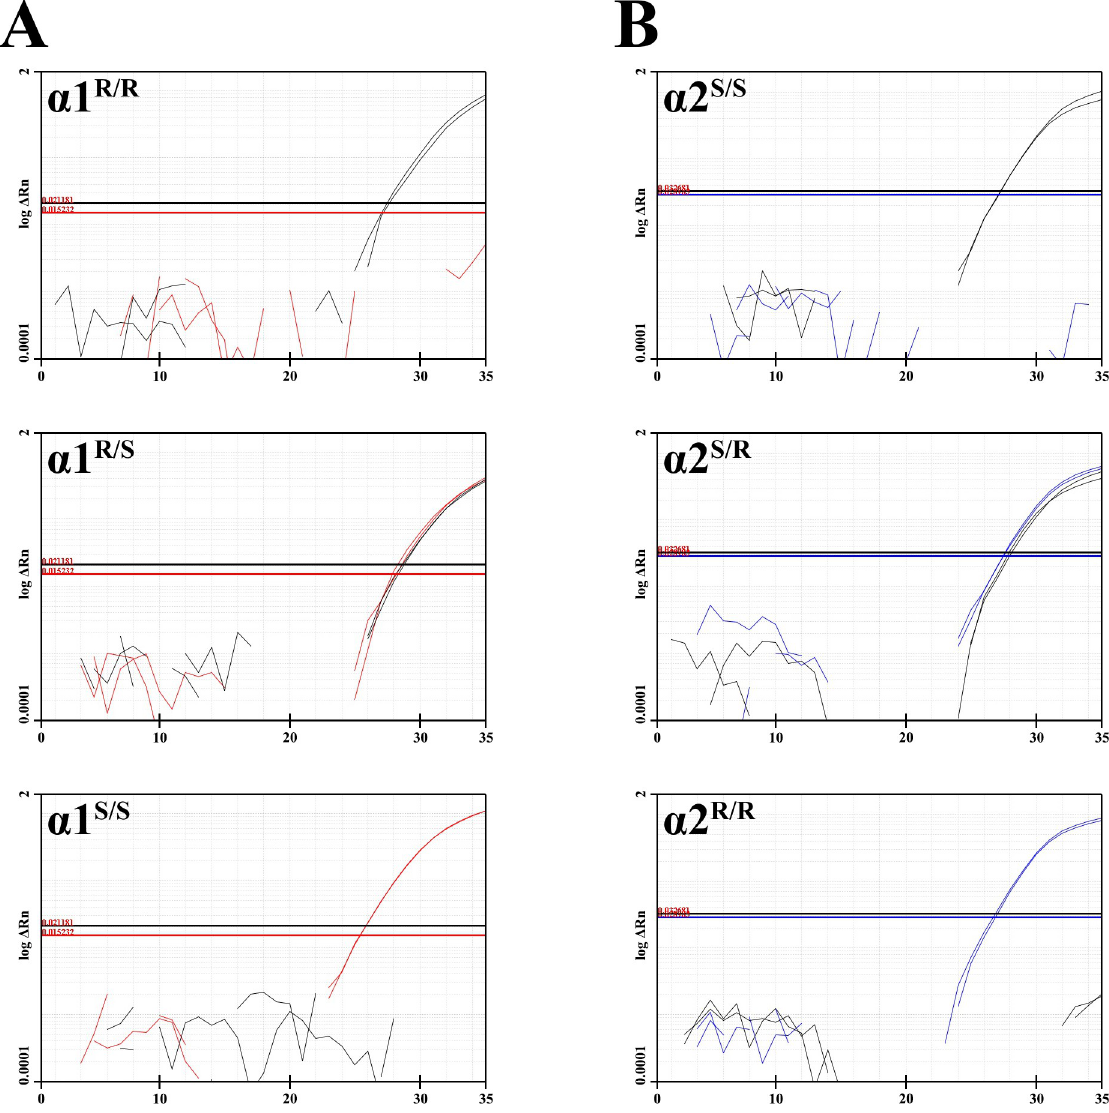
Fig 2. Detection of α 1 S and α 2 R mutants by qPCR using mutant-specific fluorescent probes. Δ Rn, fluorescence level vs. cycle number (C T ). Horizontal lines indicate threshold fluorescence level for the WT (black), α 1 S (red) and α 2 R (blue) probes. Samples considered positive for a specific allele showed C T in the range of 26-31for the corresponding probe, while negative samples did not reach threshold in 35 cycles; heterozygous samples had amplification of both probes within 2 C T of each-other. The curves from both probes (run separately, in duplicate) of each gene are superimposed onto one plot. A) Amplification plots from the α 1 (ATP1A1) assay of 3 samples representative of WT, HET, and homozygous mutant genotypes; α 1 R probe (black), α 1 S probe (red). B) Amplification plots from the α 2 (ATP1A2) assay of 3 samples representative of WT, HET, and homozygous mutant genotypes; α 2 S probe (black), α 2 R probe ( blue).